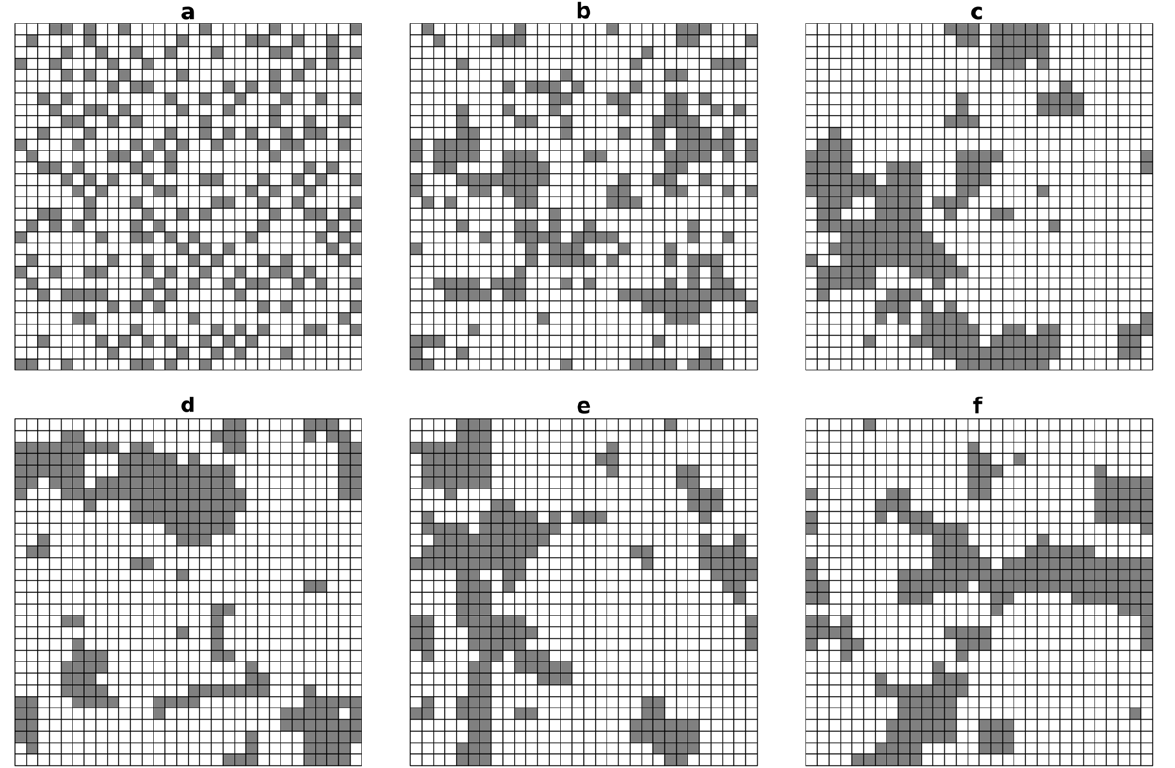
Figure 2. Distribution of habitats in the lattice environment. Distribution of habitats in the lattice environment. Habitat 1 (white) and habitat 2 (grey) represent 1 { p ~ 75% and p ~ 25% of the environment, respectively. Top row: increasing aggregation index ( AI ); bottom row: three pseudo- random habitat allocations. a: AI ~ 0 : 1 ; b: AI ~ 0 : 5 ; c, d, e and f: AI ~ 0 : 8 .